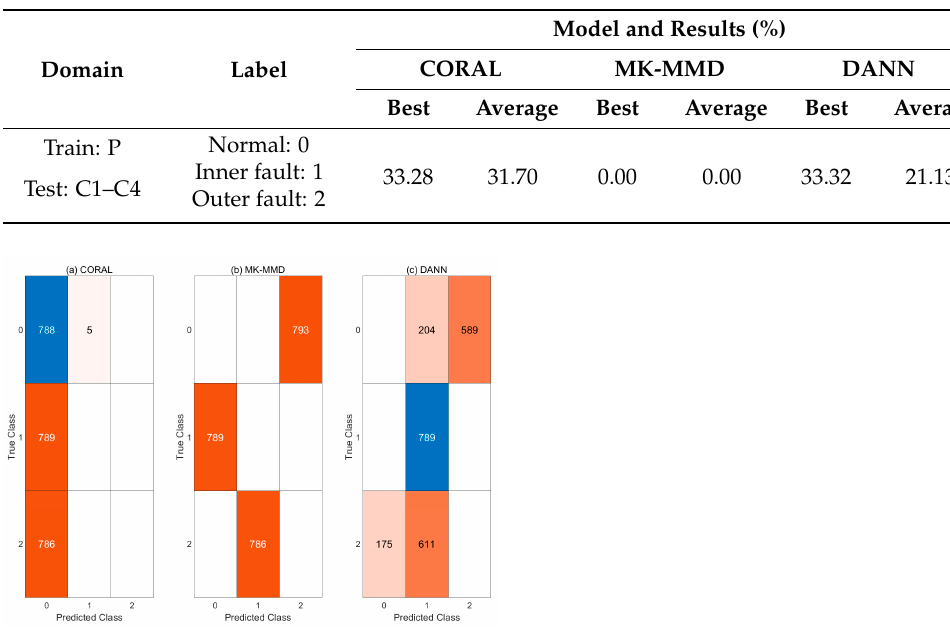
Table 5. Classification results of case 2.